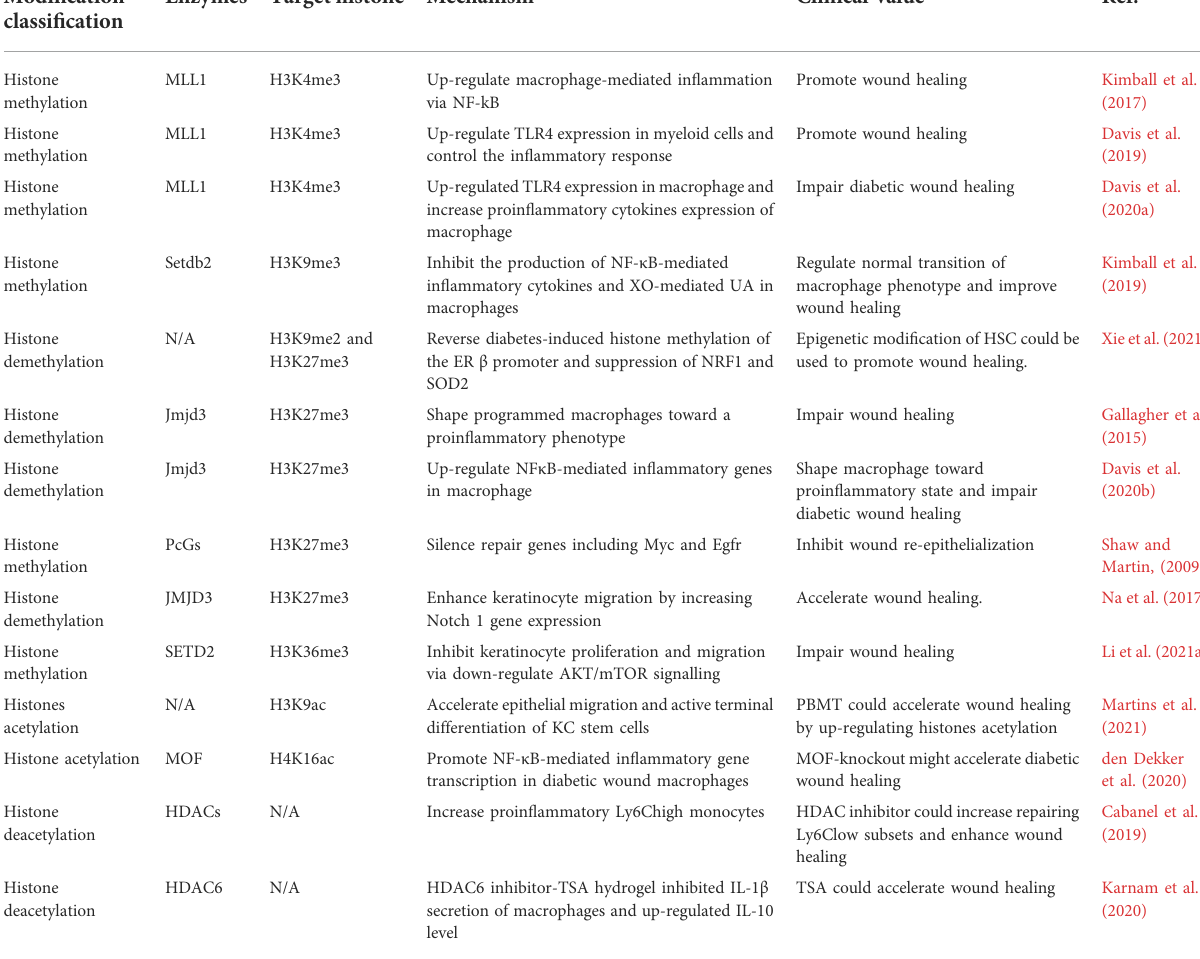
TABLE 1 Mechanisms and clinical values of histone modi fi cation in wound